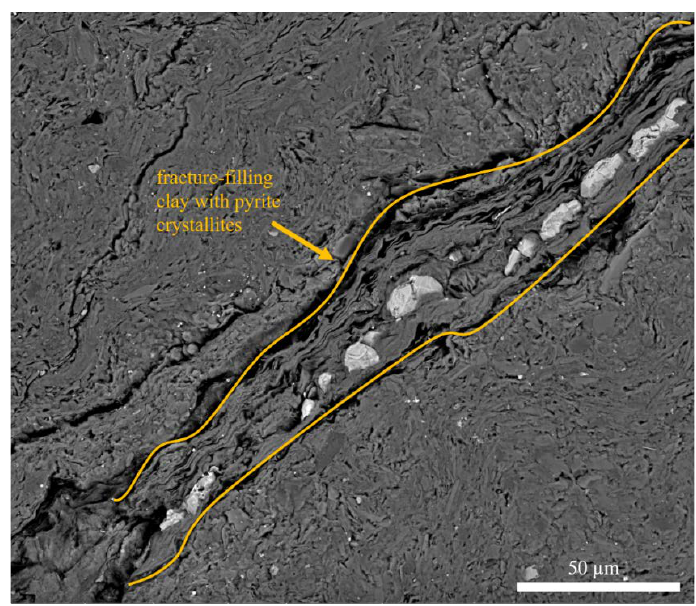
Figure 3. Fracture-filling clay with pyrite crystallites (bounded approximately by the orange markers) in Central Appalachian Basin underclay.